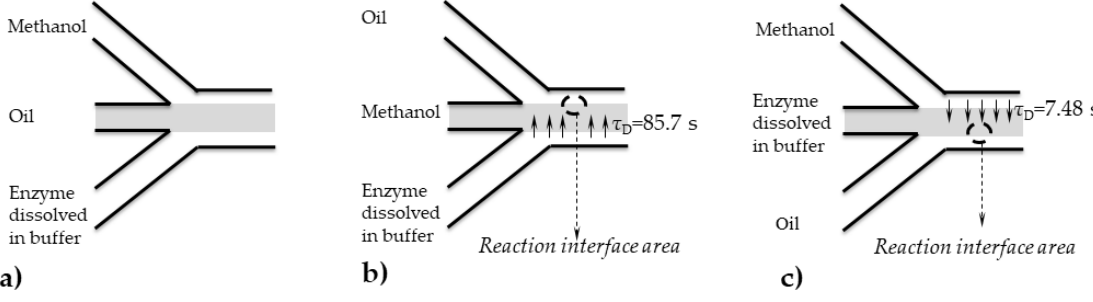
Figure 4. Inlet scheme with three different component inlet strategies, when ( a ) oil, ( b ) methanol, and ( c ) enzyme dissolved in buffer are fed in the middle channel.